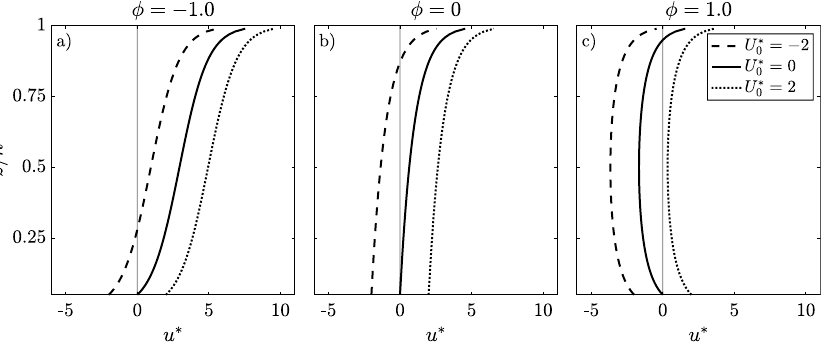
Figure 1. Velocity profiles following Refs. 9,10 , where z 0 = 0.05 h . φ is evaluated in the range φ ∈ [ − 1, 0, 1].